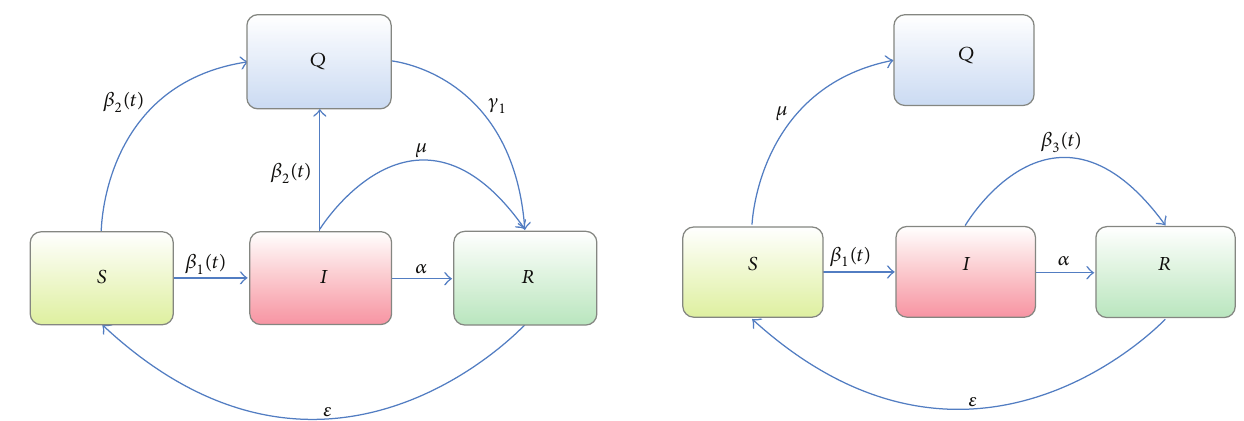
Figure 9: State transition of Situation 3.